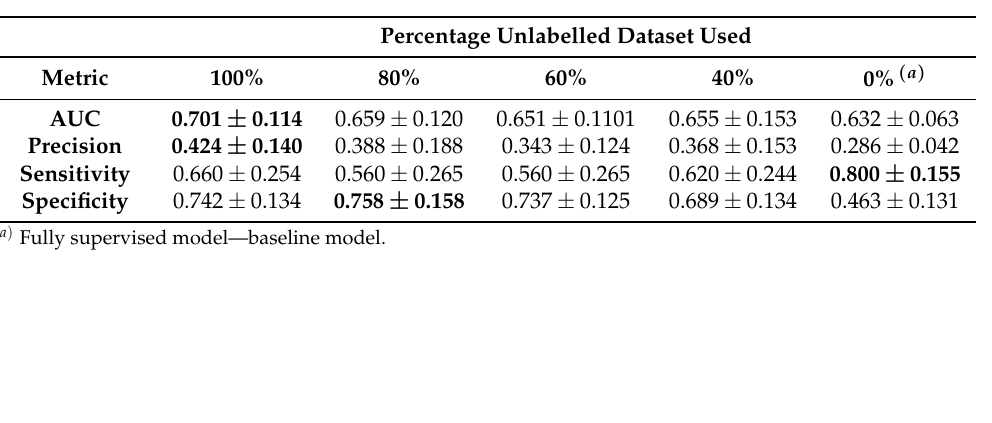
Table 8. Performance results for different percentages of the unlabelled dataset used when considering a weighted loss